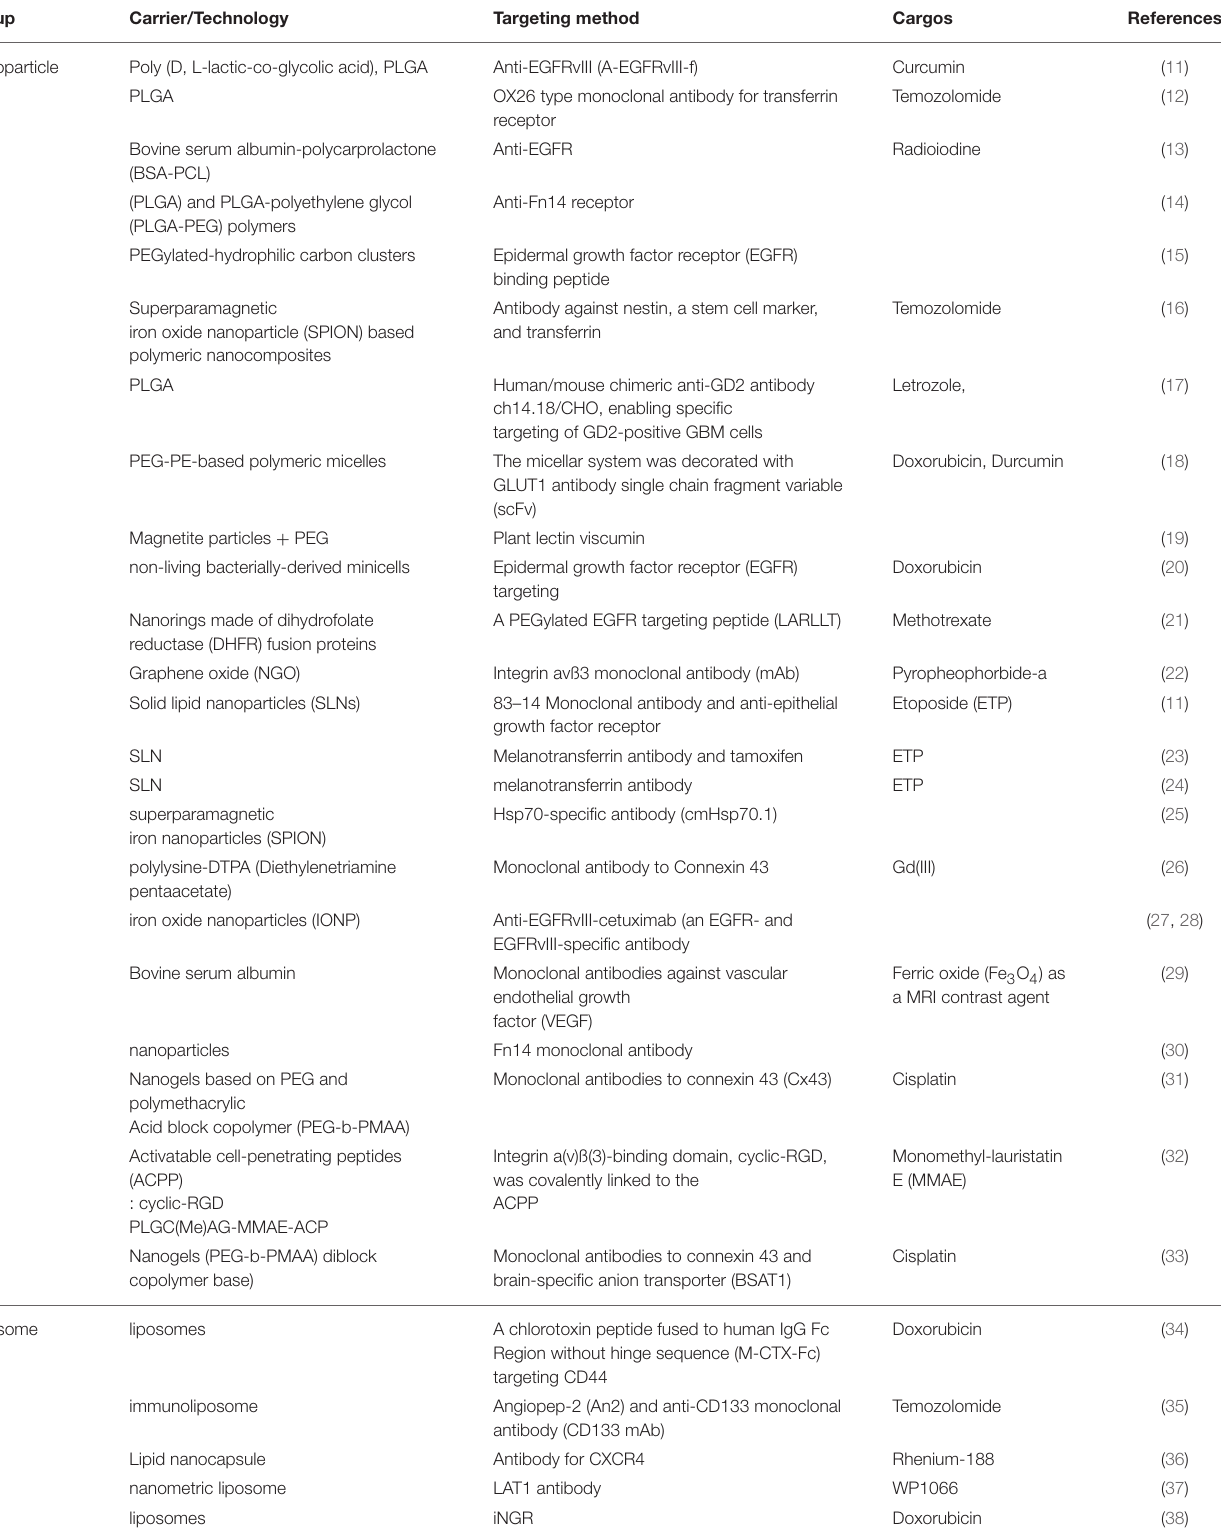
TABLE 1 | Active targeting with antibodies (or ligands) for GBM treatment.